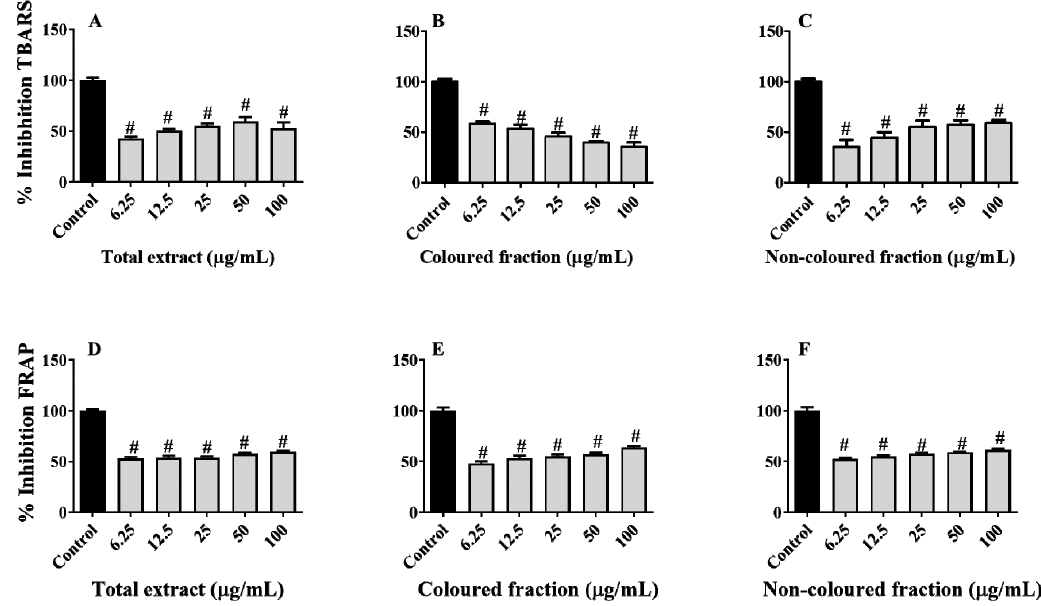
Figure 10. Ability of phenolic-enriched fractions from sweet cherries to inhibit lipid peroxidation ( A – C ) and ferric species ( D – F ) on tissue samples of porcine ( Sus scrofa ) liver. Data represent the mean ± SEM of three independent experiments performed in triplicate ( # p < 0.0001 compared to the respective control).